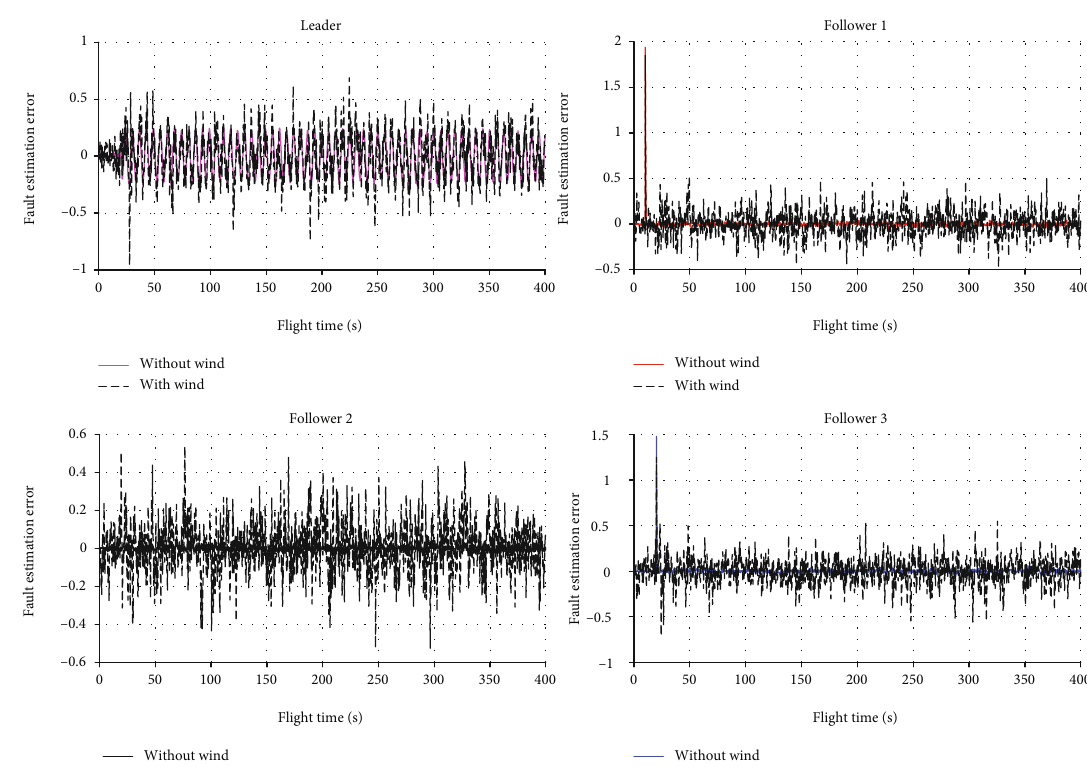
Figure 16: The fault estimation error comparison for the situations with or without